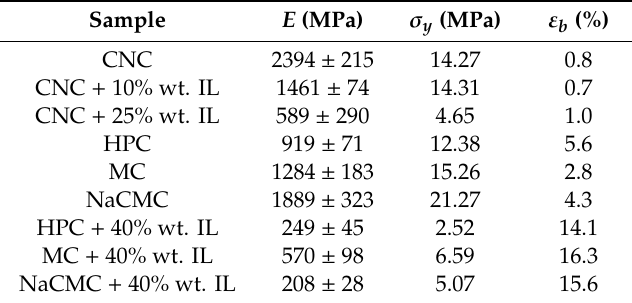
Table 1. Main mechanical parameters obtained after uniaxial tensile test for the prepared free-standing